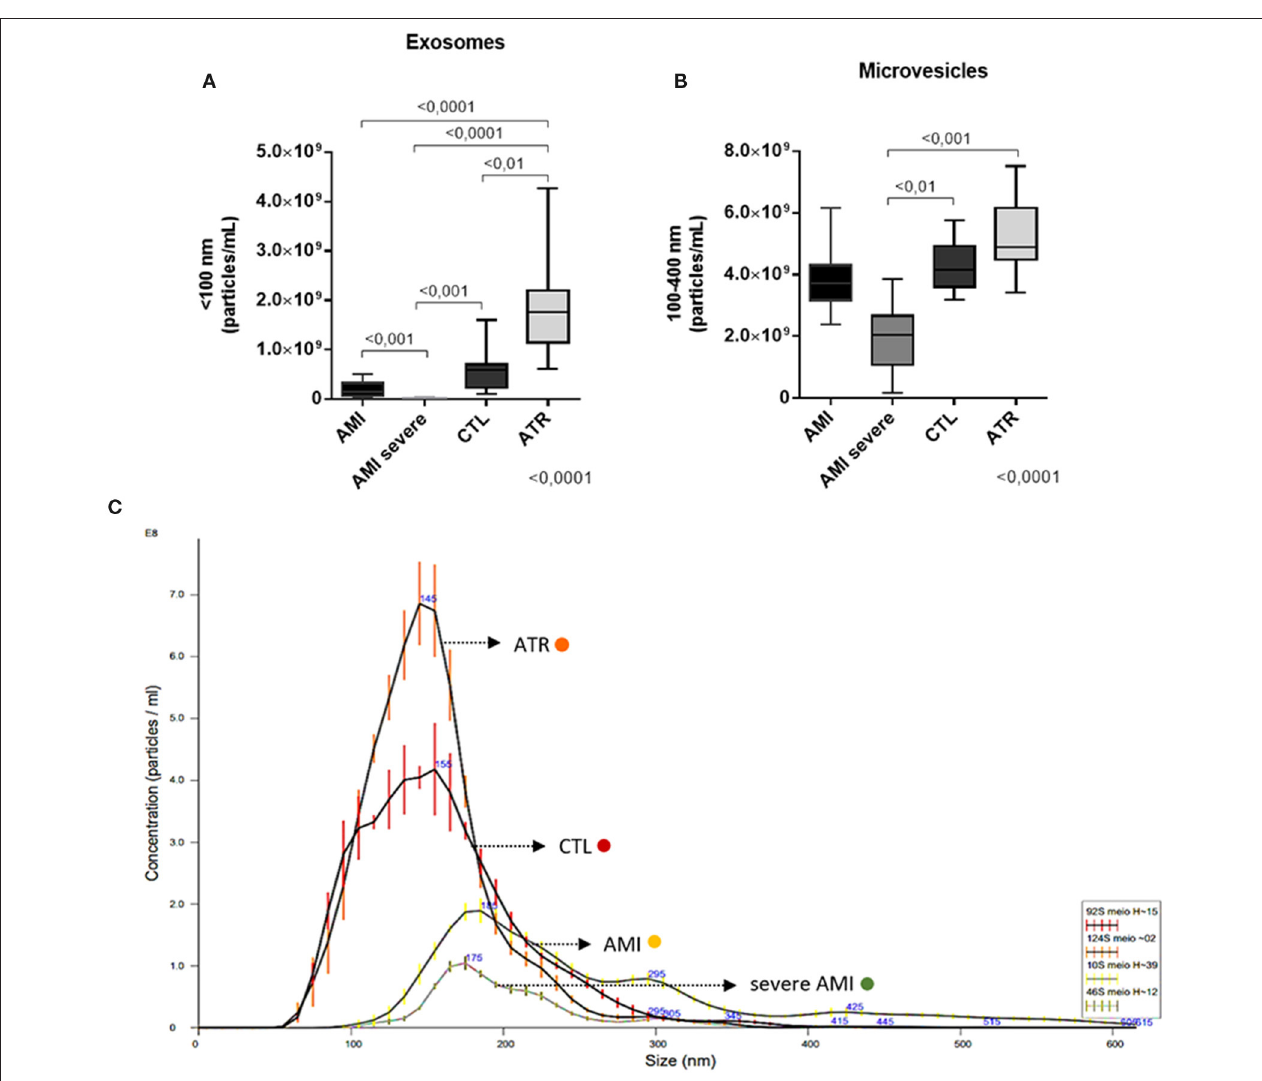
FIGURE 1 | (A,B) Absolute quantification (particles/mL) of serum exosomes ( < 100) and microvesicles (100–400nm). The decrease in circulating exosomes is accompanied by the progression of worsening evolution. In exosomes, the decrease occurs more significantly ( n = 20. per group). (C) Representative curve of the concentration and size dispersion of the total serum EVs in the different study groups (orange, ATR; red, CTL; yellow, AMI; green, severe AMI). (Data are expressed as the mean ± standard deviation). Comparison by Kruskal-Wallis with Dunn applied as a